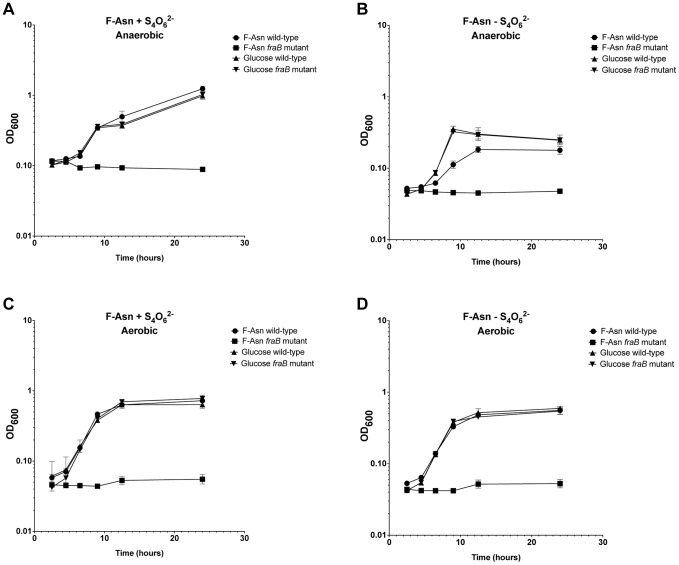
Growth of Salmonella on F-Asn in the presence or absence of tetrathionate or oxygen.Growth of wild-type MA43 and fraB1::kan mutant MA59 on 5 mM F-Asn or 5 mM glucose anaerobically (A and B) or aerobically (C and D) in the presence (A and C) or absence (B and D) of 40 mM tetrathionate (S406
2−). Bacteria were grown overnight in LB at 37°C shaking, centrifuged, resuspended in water, and subcultured 1∶1000 into NCE medium containing the indicated carbon source. The optical density at 600 nm was then read at time points during growth at 37°C with shaking. Each point represents the mean of four cultures with error bars indicating standard deviation.